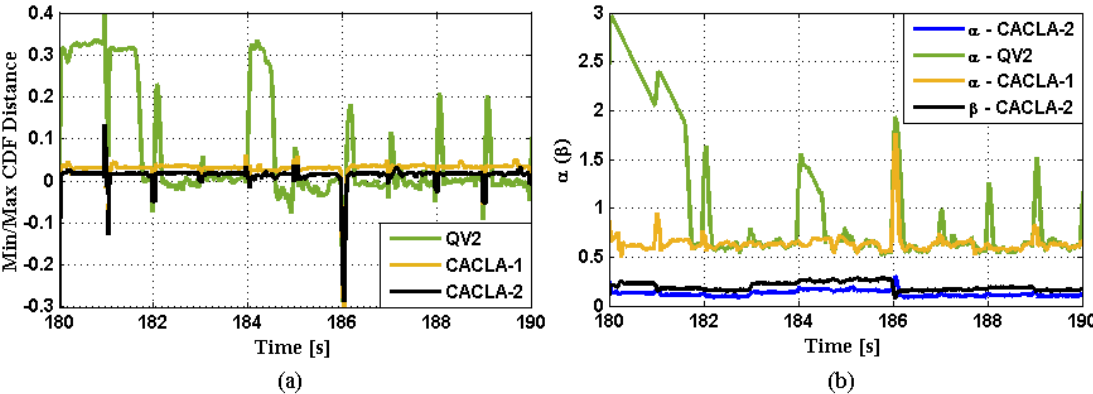
Figure 4. Learning performance: ( a ) max/min distance reported to NGMN requirement; ( b ) ( α t , β t ) evolution.